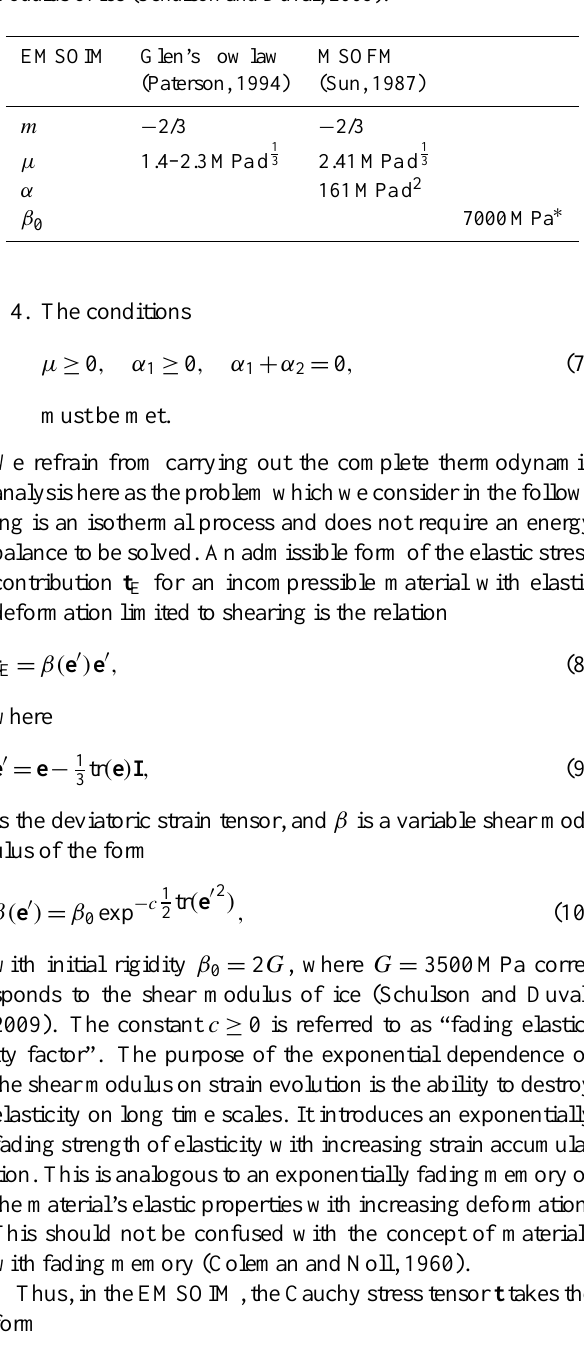
Table 2. Values for the parameters of the Glen flow law and MSOFM, available from the referenced literature, expressed for the generalized EMSOIM constitutive relation. (*) The value for the modulus β 0 corresponds to 2 G , where G = 3500MPa is the shear modulus of ice (Schulson and Duval,